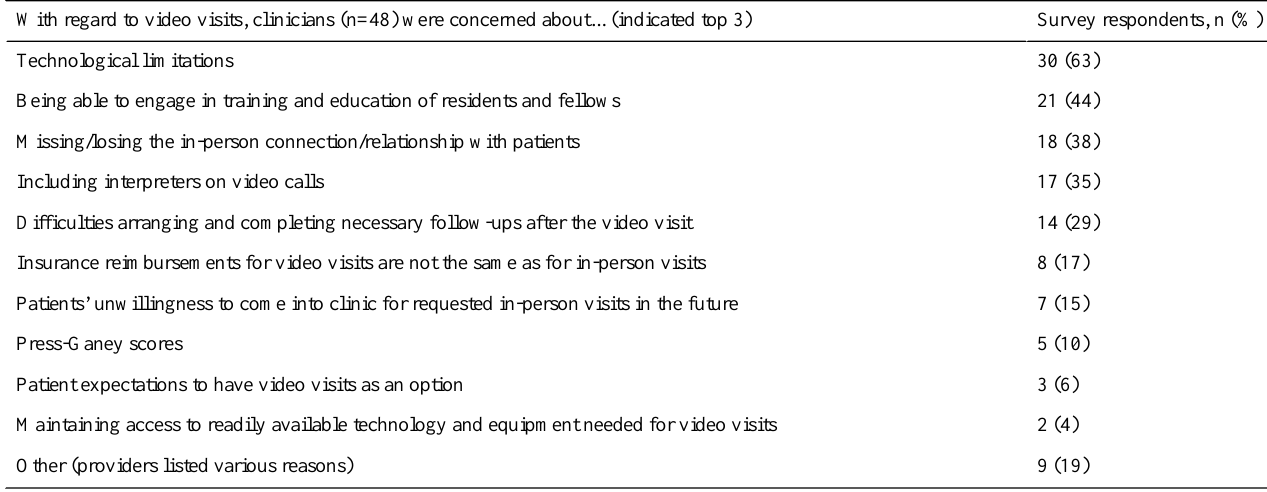
Table 3. Ambulatory neurology clinicians’(n=48) top 3 areas of concern related to video visits as reported through survey